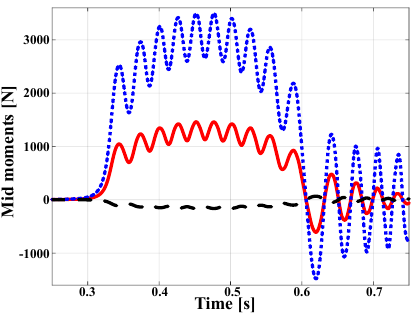
Figure 18. Bending moment M 11 (dashed line), M 22 (dotted line), and M 12 (solid line) at point M . The tip of the plate, point T , is connected to the spherical joint at point F through a very short rigid connection ( d = 0.1 mm), see Figure 15. Due to the high lateral stiffness of the crank-link mechanism, point T experiences a small displacement in the direction of unit vector ¯ ı 2 , denoted u 2 , and the corresponding velocity components is denoted v 2 .